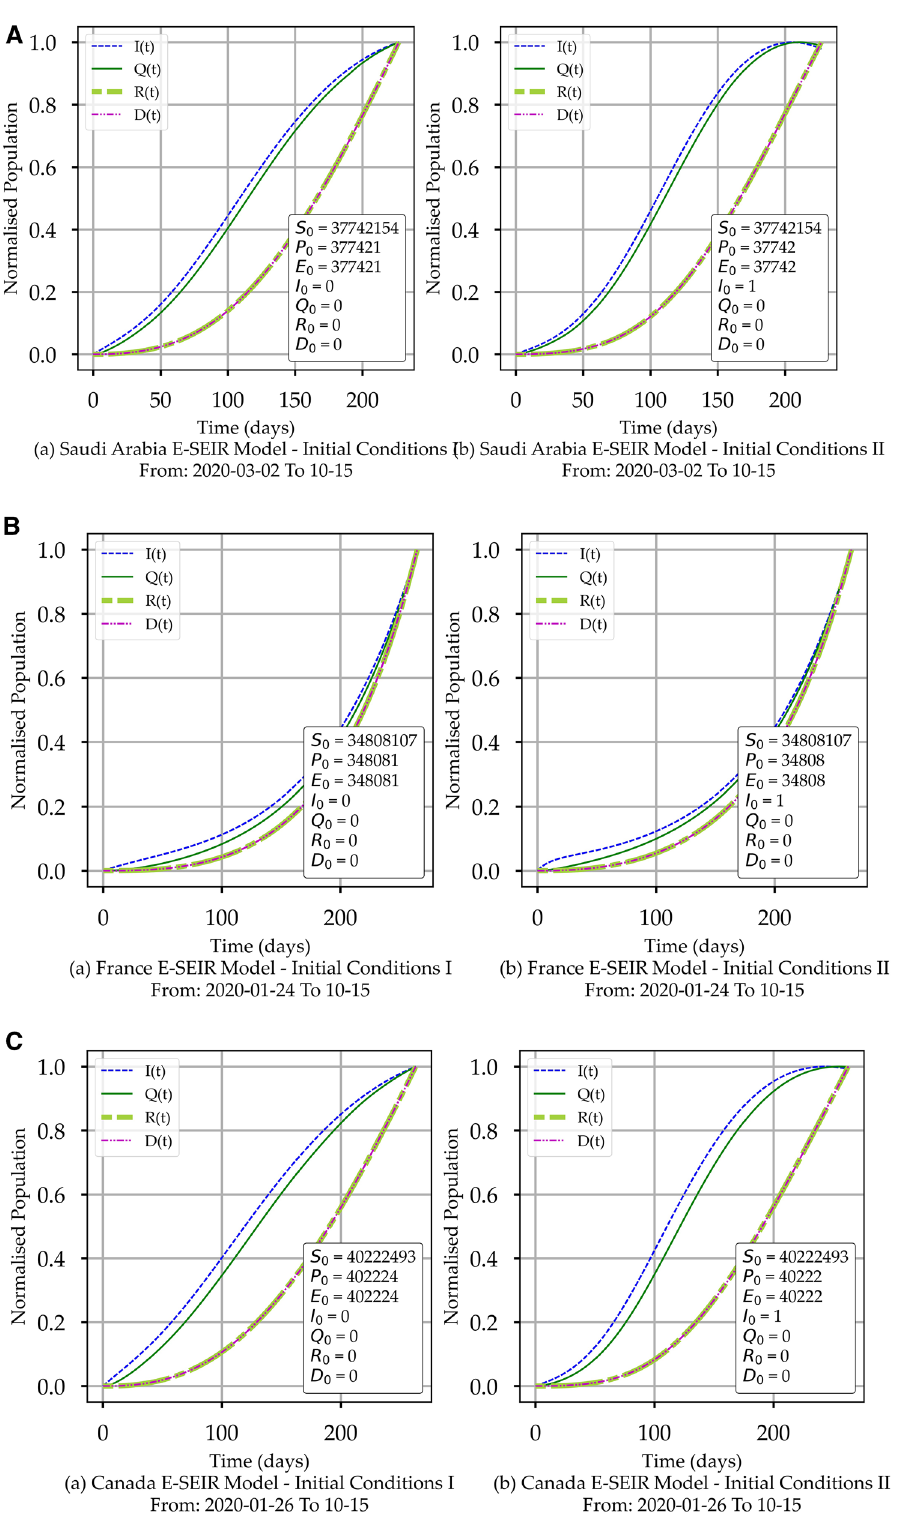
Figure 3. ( A ) COVID-19 E-SEIR Models for Saudi Arabia. (a) initial conditions I. (b) initial conditions II. ( B ) COVID-19 E-SEIR Models for France. (a) initial conditions I. (b) initial conditions II. ( C ) COVID-19 E-SEIR Models for Canada. (a) initial conditions I. (b) initial conditions